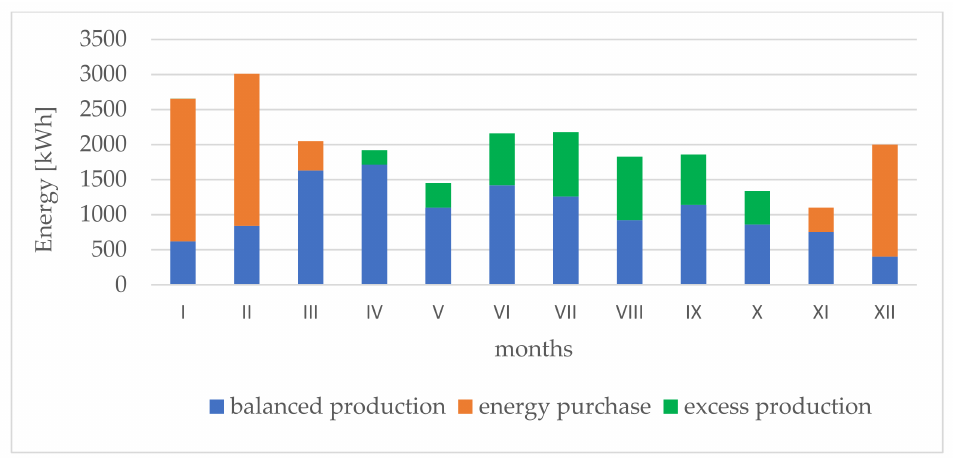
Figure 3. Summary of monthly electricity production in PV installation with an electric power of 18 kW with pump energy consumption heat with a power of 25 kW thermal power. Source: own study. Blue indicates the level of balanced energy in a month (used directly), red indicates a monthly production shortage and green indicates a surplus, i.e., overproduction.